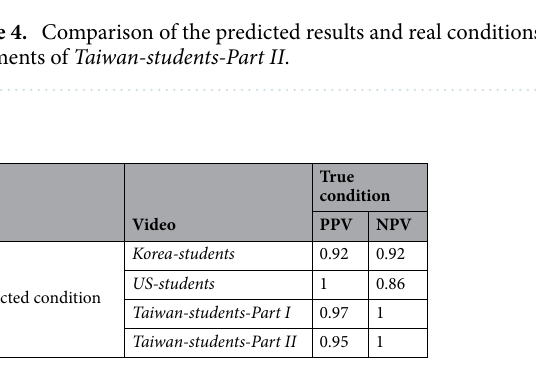
Table 5. The prediction results and real conditions of the proposed scheme with different videos are compared concerning PPV and NPV.